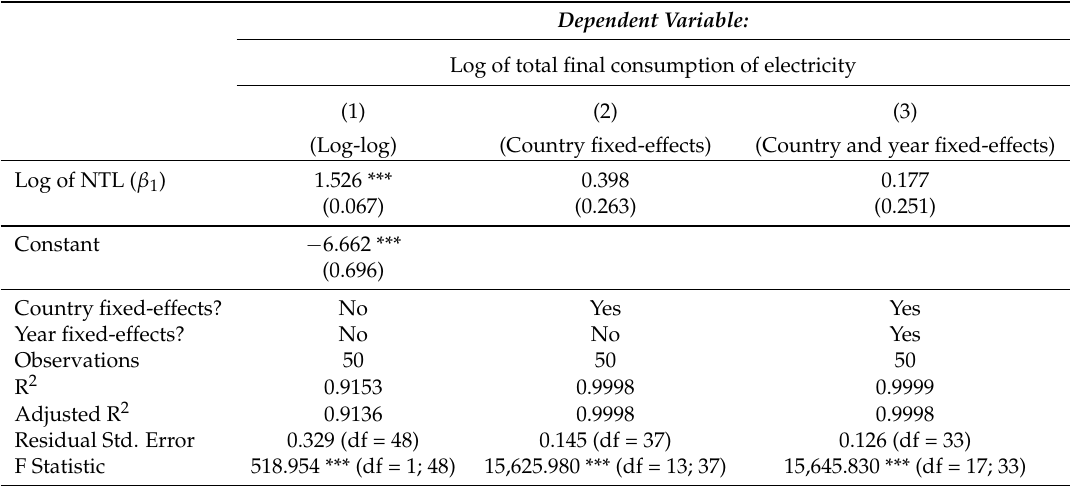
Table 3. Low-income countries regression for TFC.